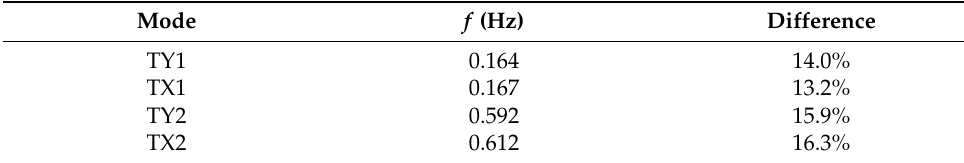
Table 2. Modal parameters predicted by FEM.